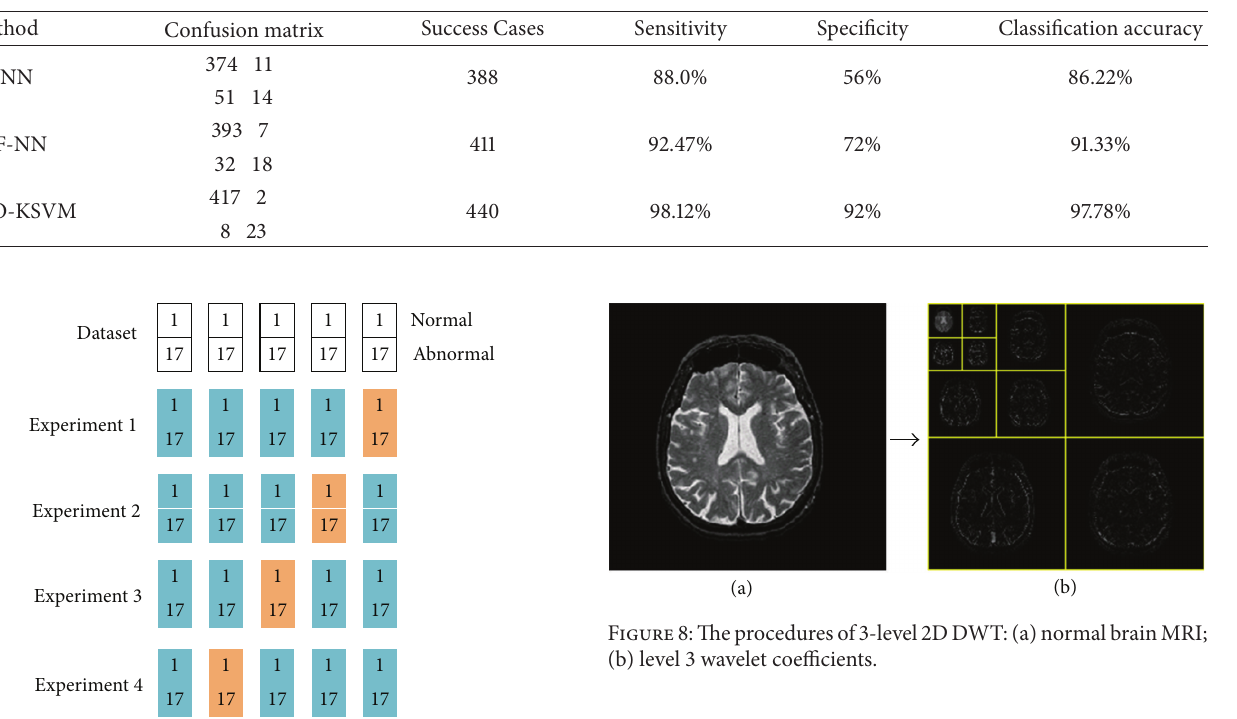
Table 2: Methods of comparison between BP-NN, RBF-NN, and PSO-KSVM.